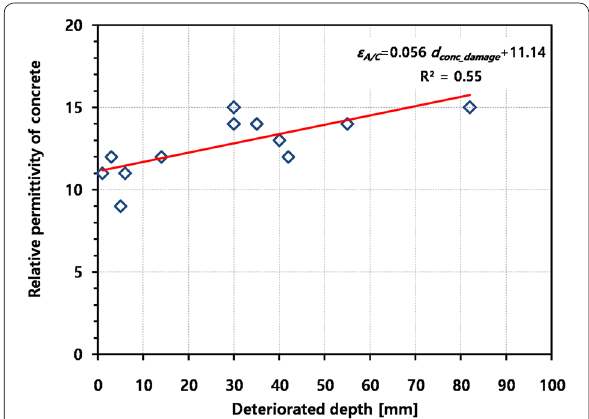
Fig. 11 Relationship between relative permittivity of concrete measured by air‑coupled GPR system on the pilot bridge and deteriorated depth measured from core